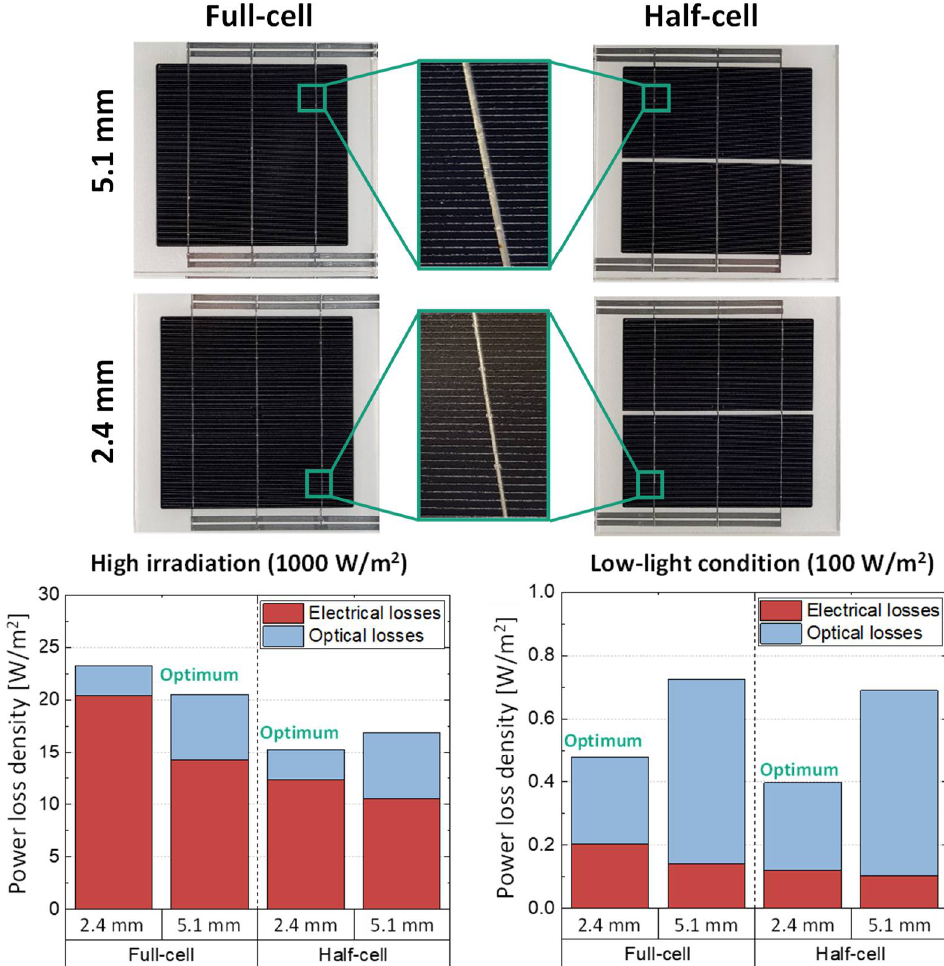
Figure 7. ( top ) Picture of half-cell and full-cell single-cell PV modules with wide and narrow tab widths which covered 2.4 mm and 5.1 mm of the cell width; and ( bottom ) the optical, electrical and overall power loss densities of the modules under high irradiation and low-light conditions.